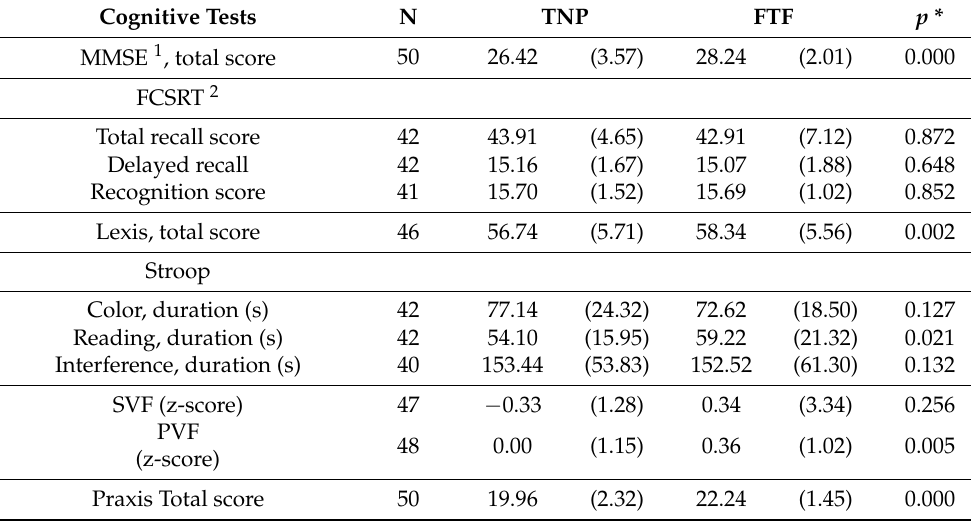
Table 3. Mean scores of the TNP and FTF